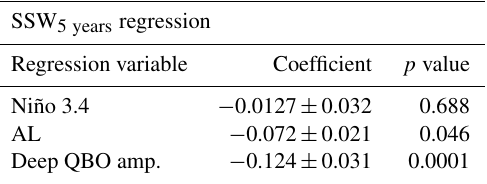
Table 2. Summary of results from multi-linear regression analysis of SSW 5 years